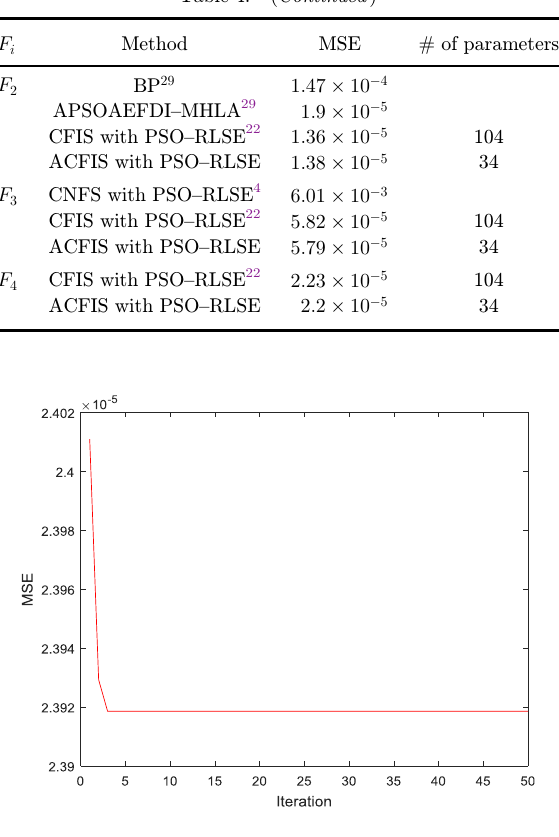
Fig. 5. Learning curve by the